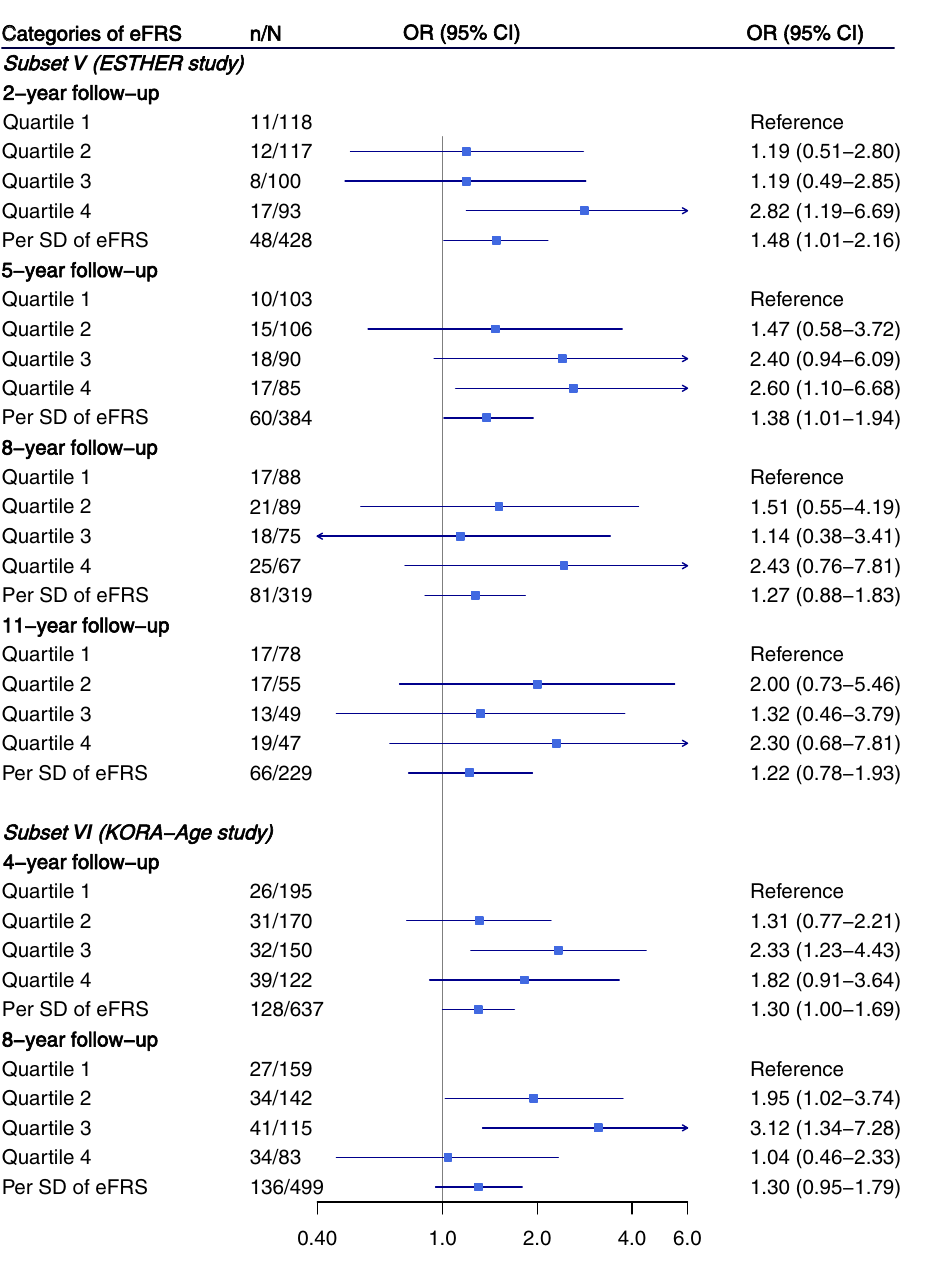
former smoker, current smoker), and alcohol consumption (g per day). eFRS epi- genetic frailty risk score, OR odds ratio, CI con fi dence interval, SD standard